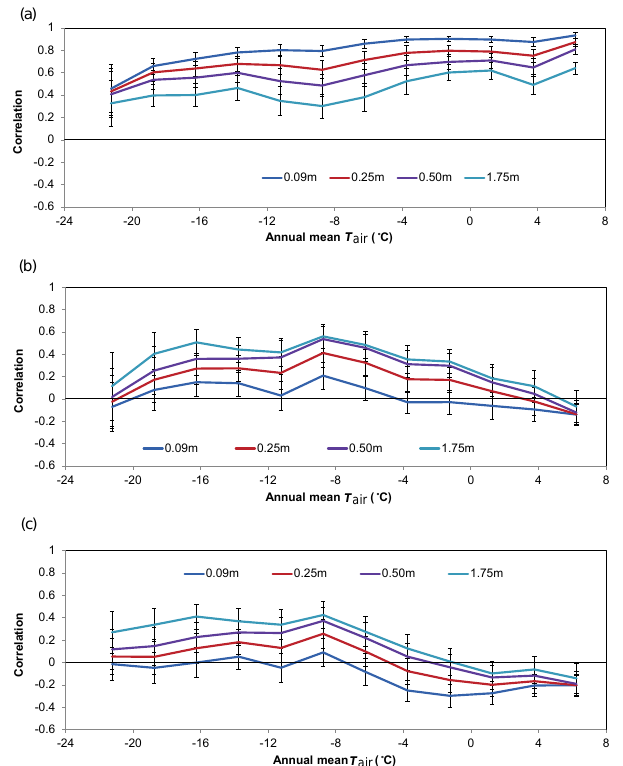
Figure 5. Correlations between climate variables and warm-season (May–October) soil temperature at different soil depths (0.09, 0.25, 0.50 and 1.75m). The climate variables used for correlation analy- sis in each panel are (a) warm-season air temperature ( T air ), (b) pre- season snow water equivalent (SWE) and (c) preseason snow cover extent (SCE). The preseason is defined as running from November of one year to April of the next. The correlations were binned into 2.5 ◦ C intervals. The standard deviation of correlations across each climate zone is shown by the error